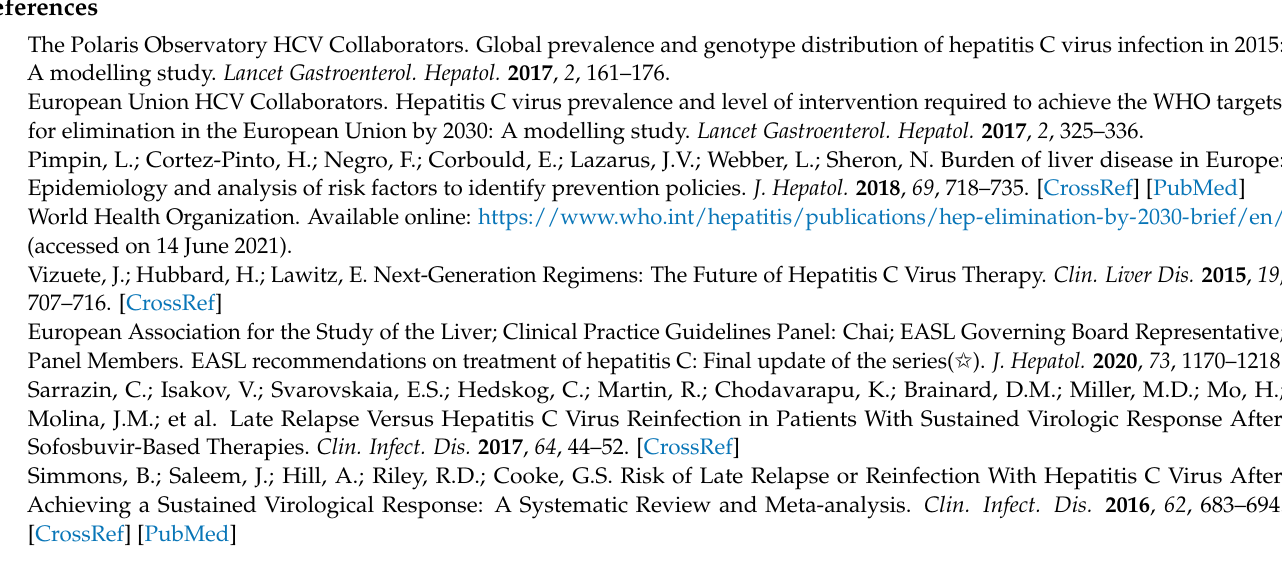
1 sequences, Figure S2: Maximum-likelihood phylogenetic tree of patient 2 sequences, Figure S3: Maximum-likelihood phylogenetic tree of patient 3 sequences, Figure S4: Maximum-likelihood phylogenetic tree of patient 4 sequences, Figure S5: Maximum-likelihood phylogenetic tree of patient 5 sequences, Figure S6: Maximum-likelihood phylogenetic tree of patient 6 sequences, Figure S7: Maximum-likelihood phylogenetic tree of patient-derived Sanger